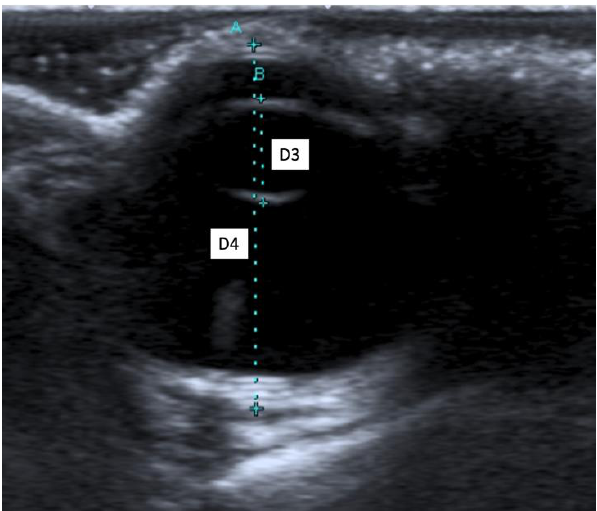
Figure 2. ( A ) The axial length of the globe (D4); ( B ) the lens thickness (D3).